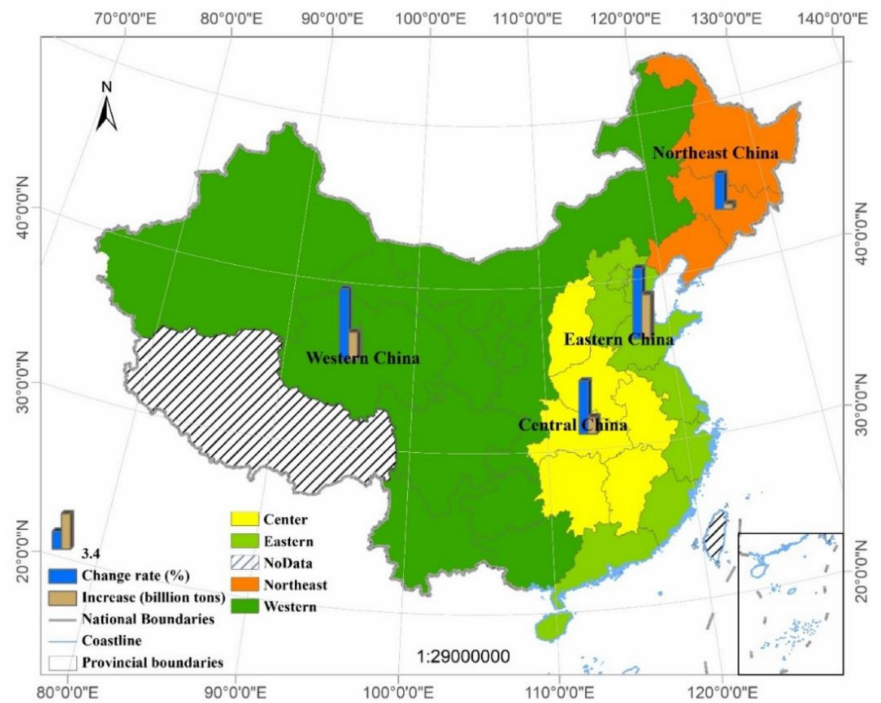
Figure 5. Four research areas in China and their corresponding CEs increments and growth rates from 1995 to 2019. The eastern part includes 11 provinces and municipalities directly under the Central Government (Beijing, Tianjin, Shanghai, Hebei, Jiangsu, Zhejiang, Fujian, Shandong, Guangdong, Hainan, and Taiwan (lack of data). The central part includes six provincial administrative units in Shanxi, Anhui, Jiangxi, Henan, Hubei and Hunan. The West includes 12 provinces, autonomous regions and municipalities directly under the Central Government (Inner Mongolia Autonomous